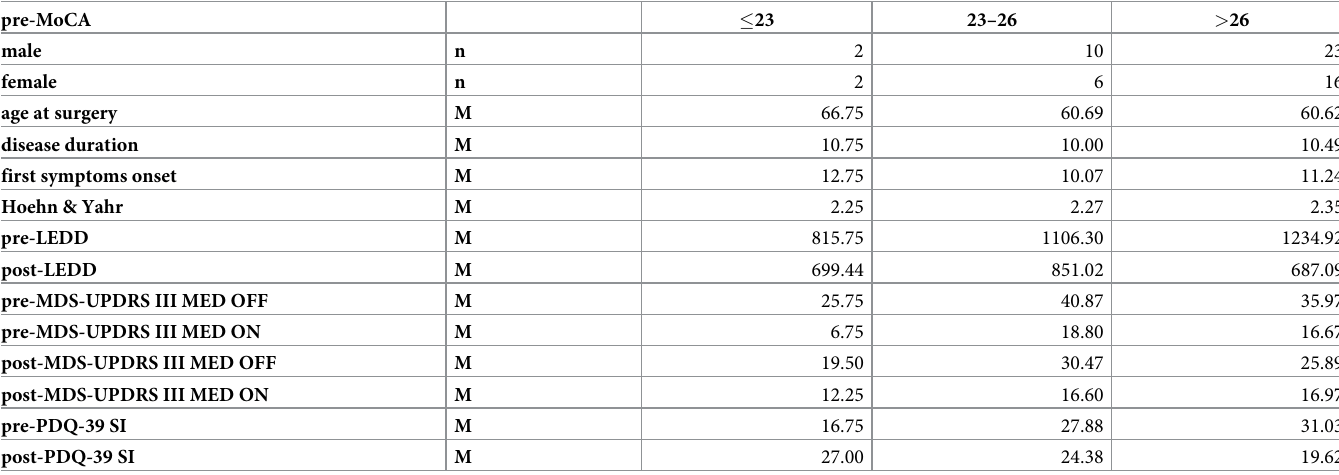
Fig 4. Conditional inference tree of preoperative MoCA and perioperative PDQ-39 SI changes. A: Conditional inference tree revealed a three-fold partitioning of patients by the pre-MoCA score. Patients scoring � 23 in the pre-MoCA had a decline of post-PDQ-39 SI. Pre-MoCA scores 23–26 resulted in a slight, but significant improvement of post-PDQ-39 SI. Patients > 26 points showed the most reliable, positive post-PDQ-39 SI improvement. B: A pre-MoCA > 23 points resulted in an improvement of quality of life. Patients with a pre-MoCA < = 23 showed a postoperative decline of quality of life. Pre: preoperative; post: postoperative; SD = standard deviation; N = number; % = percentage of patients; mean = Δ PDQ-39 mean; Δ PDQ-39 = difference of preoperative PDQ-39 SI minus postoperative PDQ-39 SI; Error bar = ± 1 standard deviations. https://doi.org/10.1371/journal.pone.0265314.g004 To date, the most commonly used preoperative cognitive screening test is the MDRS as part of the CAPSIT protocol [12]. The MDRS provides several advantages compared to other cognitive scales. First, it is a recommended cognitive rating scale with fine clinimetric proper- ties and normative data as well as cut-offs for dementia ( � 132) [14] and MCI ( � 137) [6, 15]. A cut-off score of � 120 represents a discriminatory value for the diagnosis of Parkinson’s dis- ease dementia (PDD) [18]. Second, the MDRS comprises cognitive subscales to administer specific, different cognitive domains, especially executive and attentional function [11]. This is relevant since the executive domain is particularly impaired in PD patients [19]. Third, in one Table 2. Comparison of patient characteristics in relation to MoCA